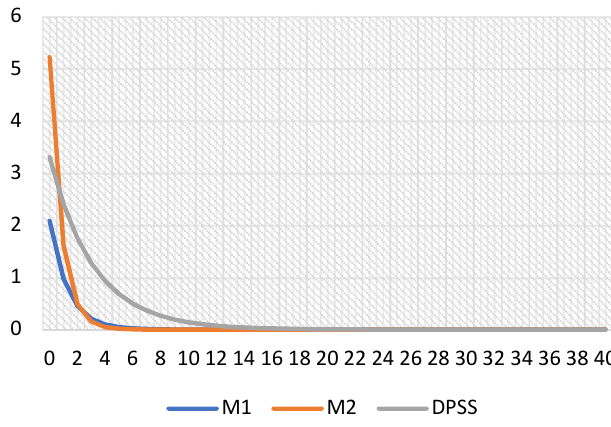
Figure 1. Positive shock to Global Demand on Oil price. Oil Price shock on Real Exchange rate—Figure 2 Real exchange is not available for DPSS; therefore, they are not included for comparison. A positive oil price shock of one standard error was applied to all four models. For the DSGE–GVAR type models, both M1 and M2, as shown below, show that the real exchange rate tends to react strongly during the first few quarters to shocks, but often cycles back to steady-states a few quarters later. In particular, regions that are oil export-led, such as Latin America, Norway (ODC), and the UK, show that USD depreciate against them when oil prices increased. Conversely, big importers had their currencies depreciated against the USD, such as Japan (USD > JPY; therefore, showing a 1% increase of USD against JPY). Most regions, however, showed a low reaction, such as the Eurozone and ROW. This closely resembles what is observed in real life, as exchange rates tend to be stable around an equilibrium and should not drift, unless there is a strong economic situation, such as a currency devaluation. Including the 2020 data did not create much difference, although the effects were more pronounced for Latin America, but not significant. However, the DSGE-HP type models H1 and H2 showed IRFs that were not stable. This is shown in the graphs below, as none of the shocks apart from ROW returned to the steady-states; therefore, they are not stationary, nor stable enough to derive any conclusions. This is since using a HP filter diminished any meaningful cycles in the time-series; therefore, they have not captured any important features from history.